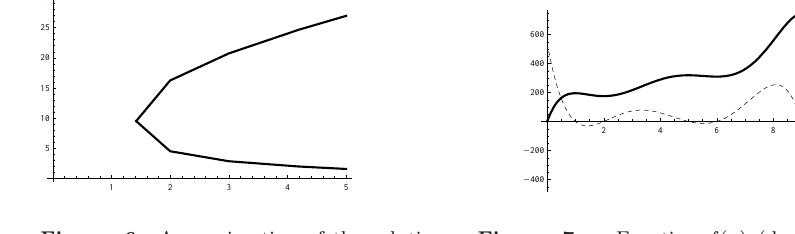
Figure 7. Function f ( x ) (dashed) and F ( x ) = R x 0 f ( s ) ds.